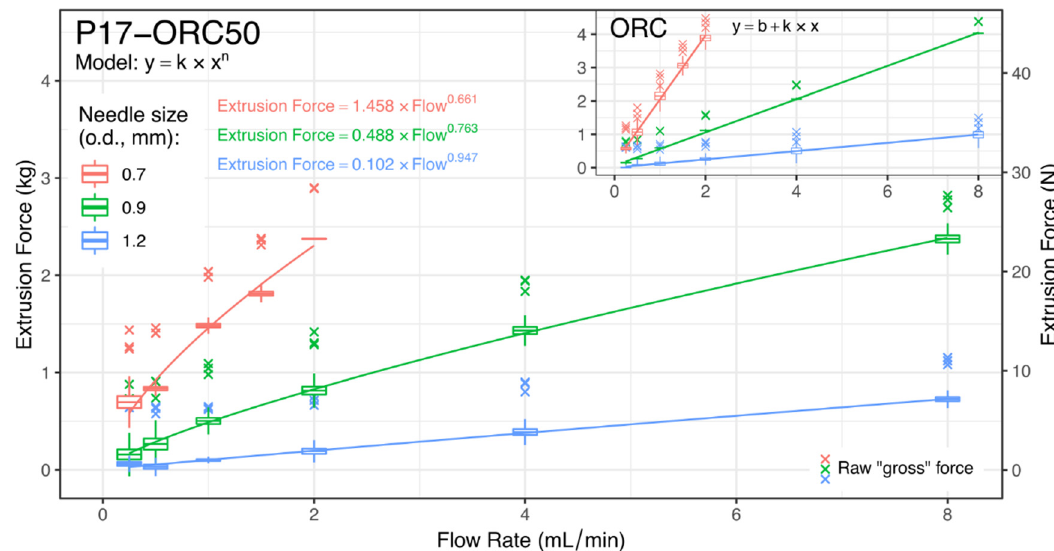
Figure 11. Syringeability study results in P17–ORC50 blank emulsion. Inset shows results obtained for pure ORC oil, with the same y-range as in the main plot. A linear fit is applied for pure ORC. Models and box-and-whiskers plots were calculated upon net extrusion force, while raw (gross) data was also shown for a better consideration of the actual force needed to move the plunger.